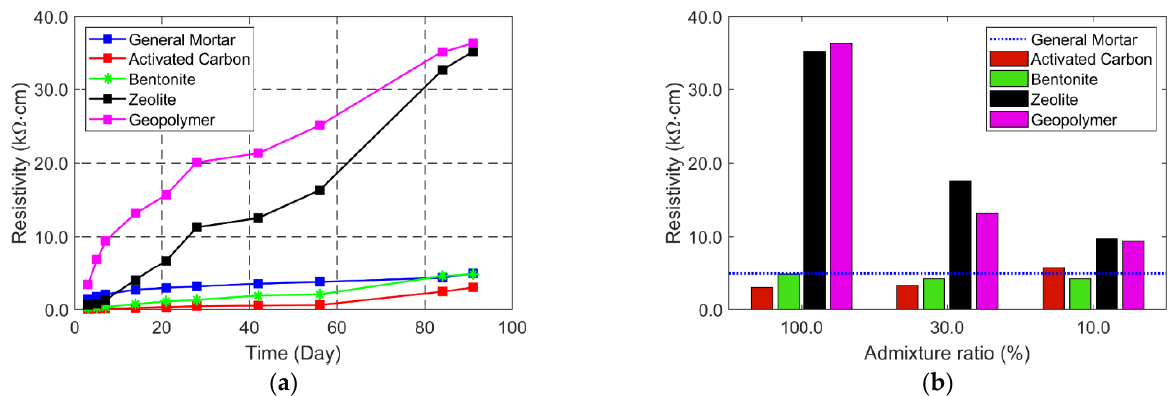
Figure 3. Resistivity variations during the 90 days after mortar specimens were made (an admixture